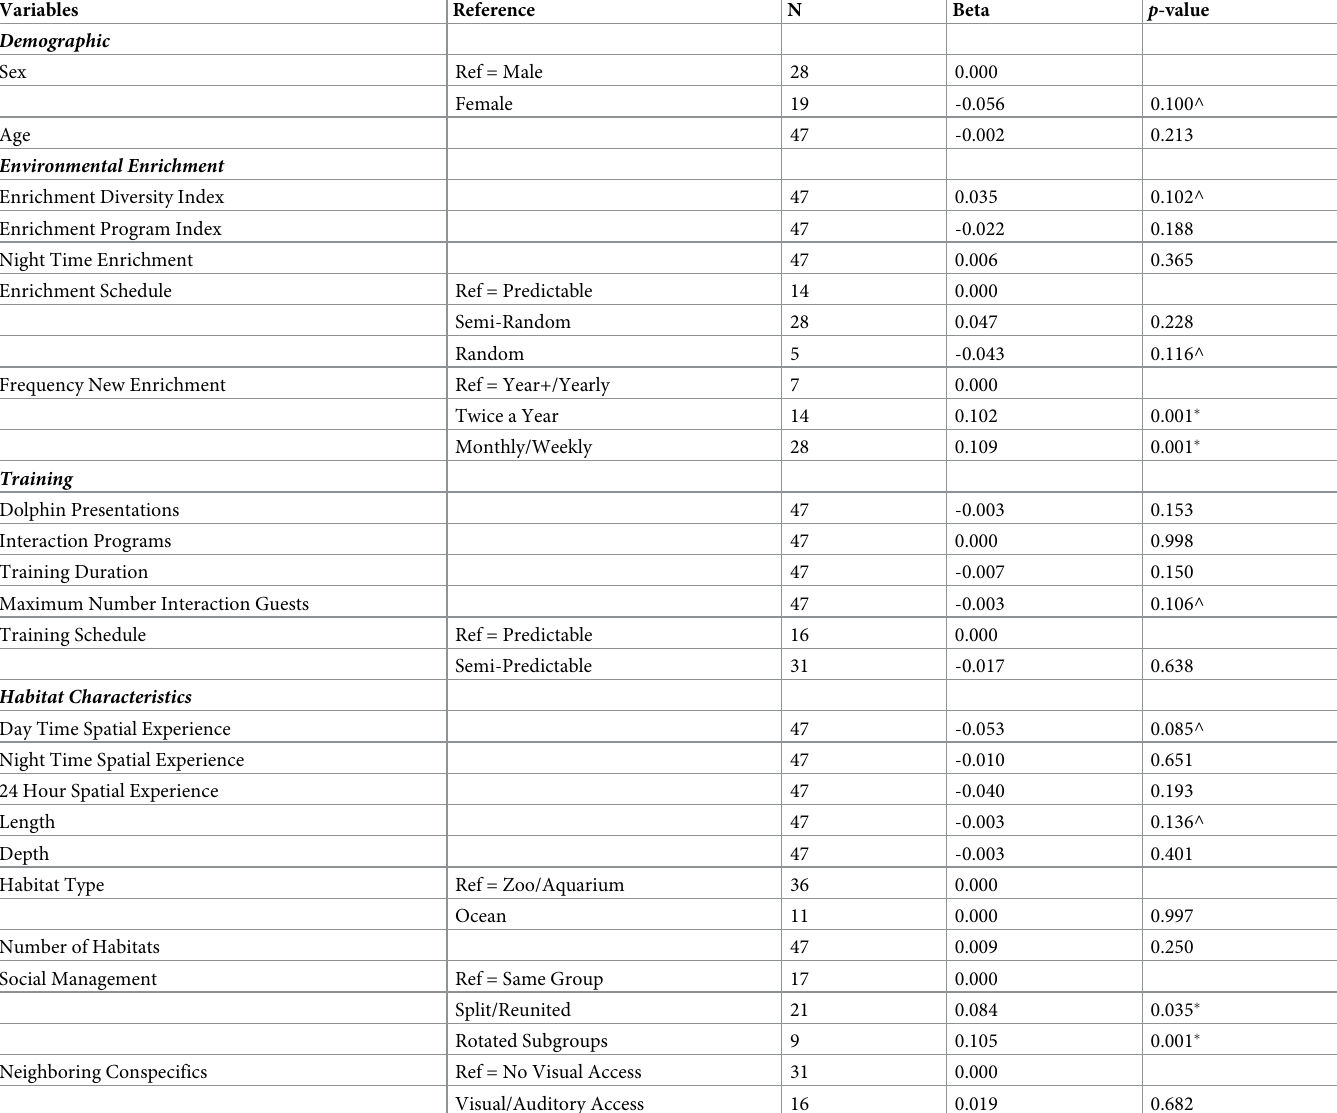
Table 5. Summary of univariate analysis for relationships between independent variables and interact with conspecific